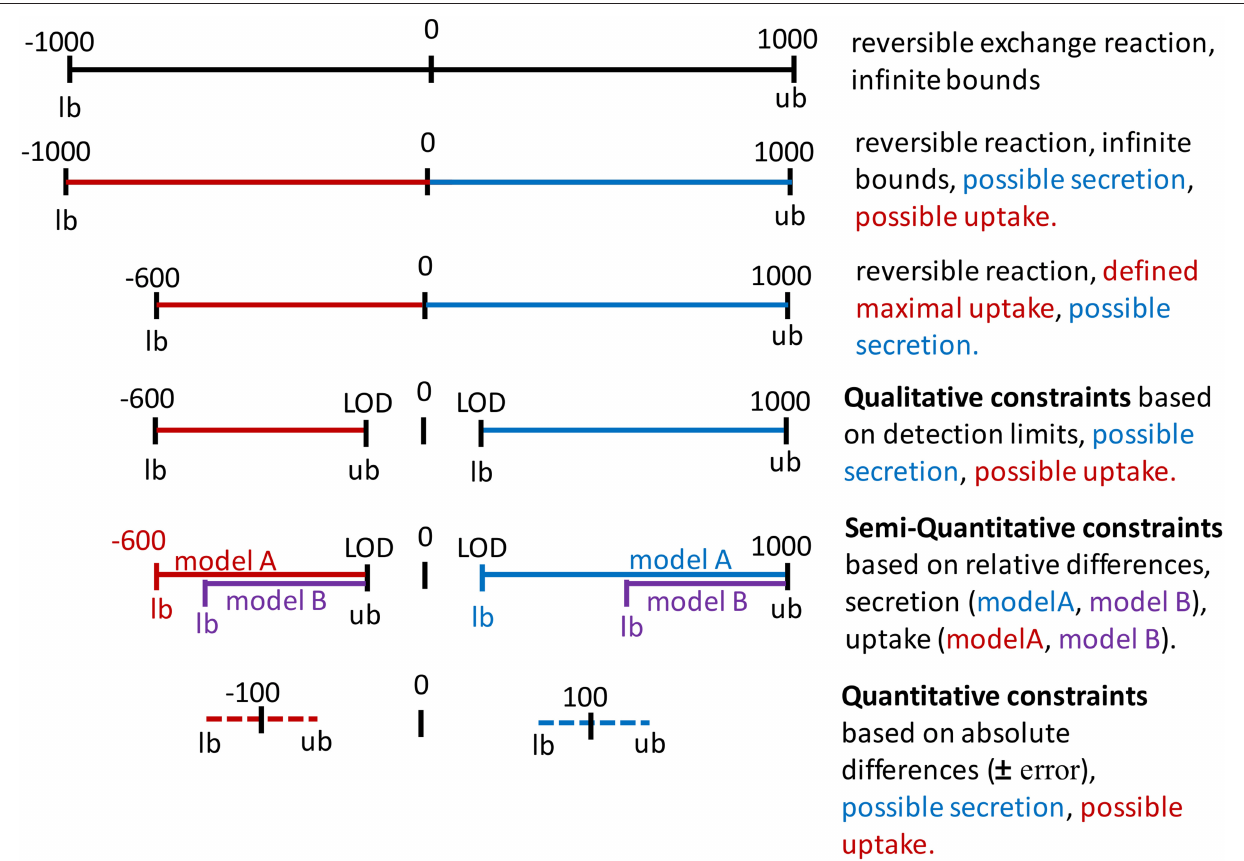
FIGURE 4 | Application of constraints on the bounds of exchange reactions. Infinite bounds (here, − 1000 to 1000) express the unlimited supply and removal of metabolites to and from the system. A negative flux through an exchange reactions corresponds to an uptake (red) and a positive flux corresponds to the secretion of a metabolite (blue). Maximal uptake can be constraint by restricting the lower bound (lb = − 600). The directionality of the exchange can be defined by setting a negative value as the upper bound (ub) for an uptake or by setting a positive value as the lower bound for secretion. These constraints could be based on the limit of detection (LOD) or quantification for the metabolite. Relative differences in the uptake and secretion of a metabolite can be expressed as the relative difference from maximal possible uptake rate (purple as compared to red) and as the relative difference from the minimal secretion rate. Absolute concentration changes over time can be converted to flux values and added to the constraints, considering a user-defined error to the flux to define lower bound and upper